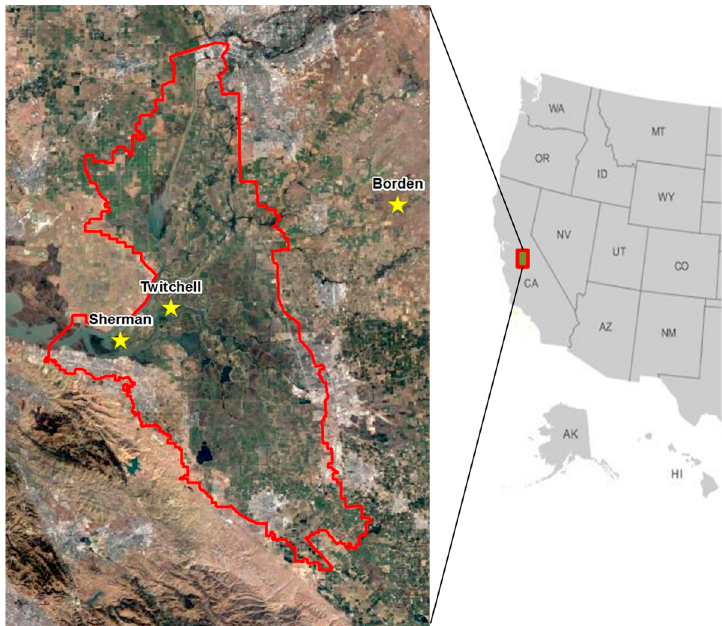
Figure 1. Study domain covering the Sacramento–San Joaquin Delta in California’s Central Valley. The Legal Delta Area is delineated in red, with flux tower sites on Twitchell and Sherman Islands and in vineyards in the Borden Ranch area indicated with yellow stars.